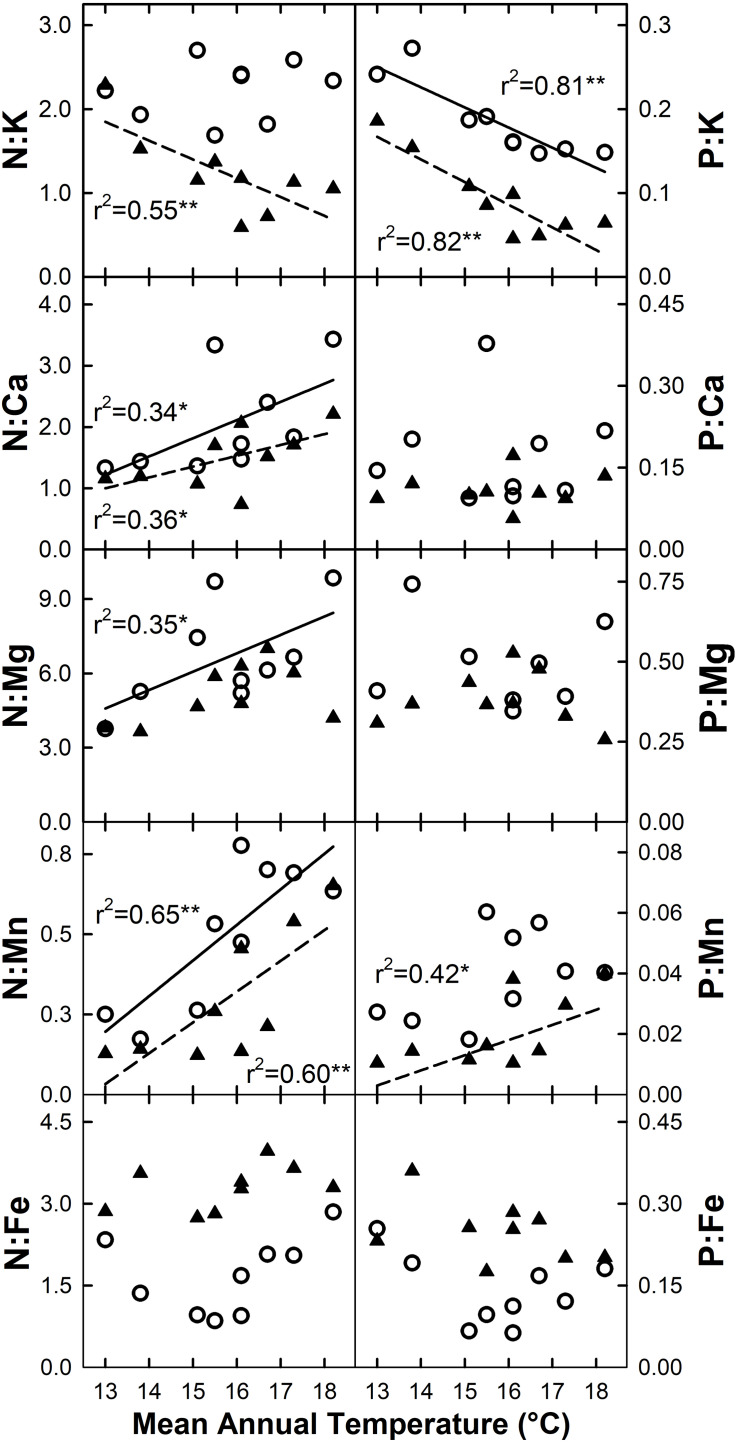
Stoichiometric responses of live foliage nitrogen (N) and phosphorus (P) ratios with micro- and macronutrients for M. polymorpha (open circles and solid regression lines) and C. trigynum (closed triangles and dashed regression lines) across a 5.2°C mean annual temperature gradient in Hawaiian tropical montane wet forest. Significance of regression is indicated as *P < 0.10 and **P < 0.05.